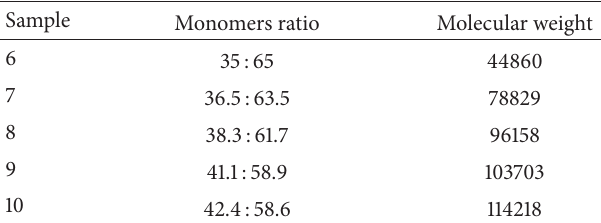
Table 4: Dependence of molecular weight of MF samples (6–10) on monomers ratios.